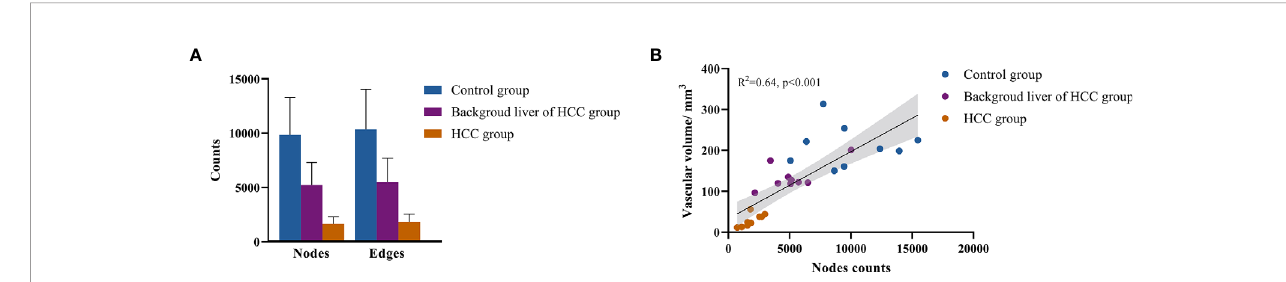
FIGURE 3 | Scale of vascular network. (A) Nodes and edges counts; (B) relationship between nodes counts and segmented vascular